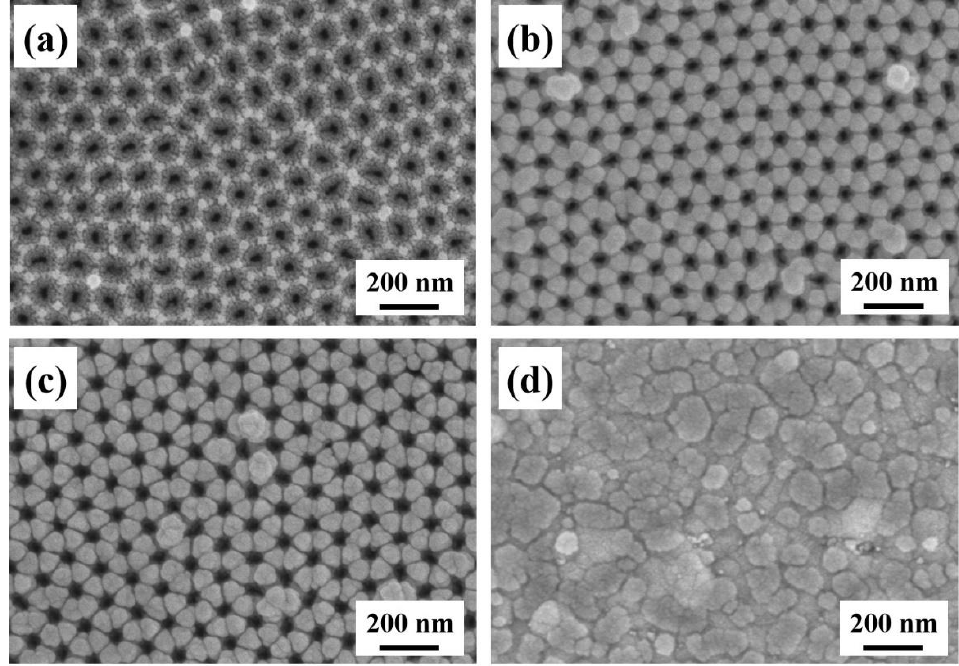
Figure 4. FE-SEM images of ( a ) Ag 10 -AAO, ( b ) Ag 15 -AAO, ( c ) Ag 20 -AAO and ( d ) Ag 25 -AAO sub- strates with different sputtering times. substrates with different sputtering